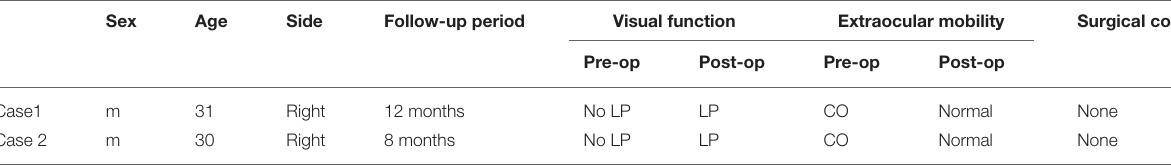
TABLE 1 | Demographic and pre- and post-operative visual and extraocular mobility functions of two cases with TOAS.